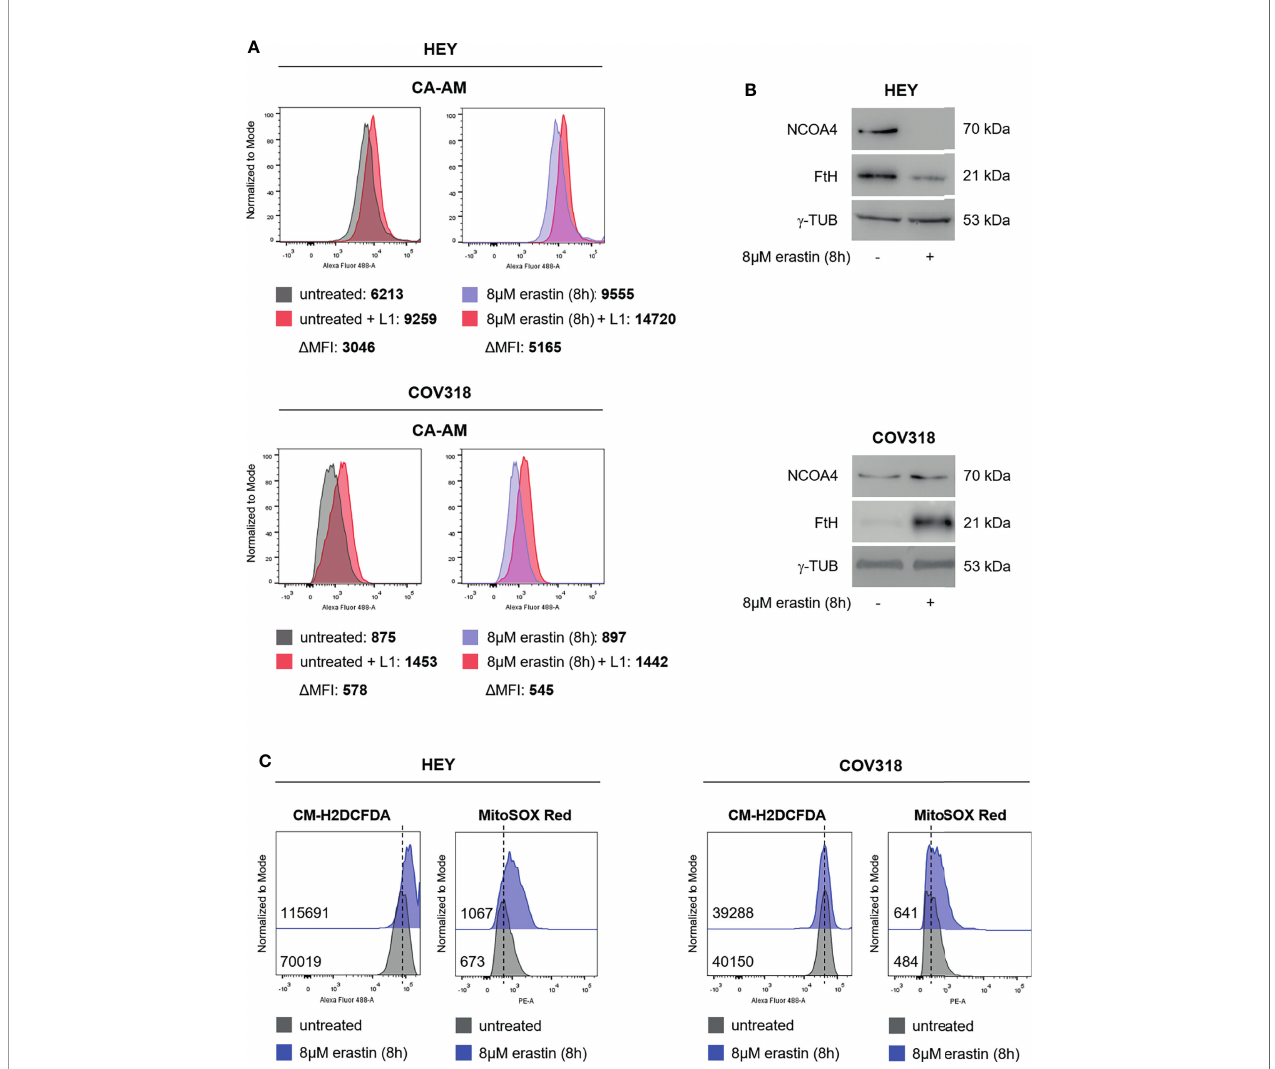
FIGURE 2 | Erastin promotes ferroptosis in HEY cells, but not in COV318 cells. (A) LIP level assessed by fl ow cytometry using CA-AM in HEY and COV318 cells upon treatment with 8 µM erastin for 8 h. (B) Western Blot analysis of NCOA4 and FtH in HEY and COV318 cells untreated or treated with 8 µM erastin for 8 h. g - TUB was used as internal control. (C) Flow cytometry analysis of cytosolic and mitochondrial ROS production after erastin administration (8 µM erastin for 8 h). Cytosolic ROS were measured upon staining with CM-H2DCFDA while mitochondrial ROS were quanti fi ed by using MitoSOX Red. Results are representative of three independent